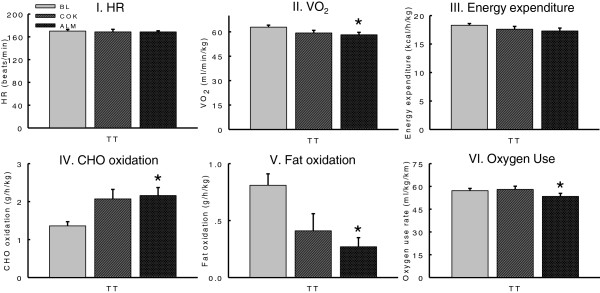
Main physiological records and gas exchange analysis throughout TT. Several main physiological parameters (HR, heart rate, and VO2, oxygen uptake) throughout TT were recorded as described in the Methods. Energy expenditure (EE), carbohydrate and fat oxidation, and oxygen use were calculated as described in the Methods. No significant differences in HR and EE among BL, ALM and COK (P > 0.05) were found. ALM (not COK) had higher carbohydrate (CHO) oxidation, lower oxygen uptake (VO2), fat oxidation and oxygen use as compared with BL (*P < 0.05), whereas there were no difference in VO2, CHO and fat oxidation and oxygen use between ALM and COK.